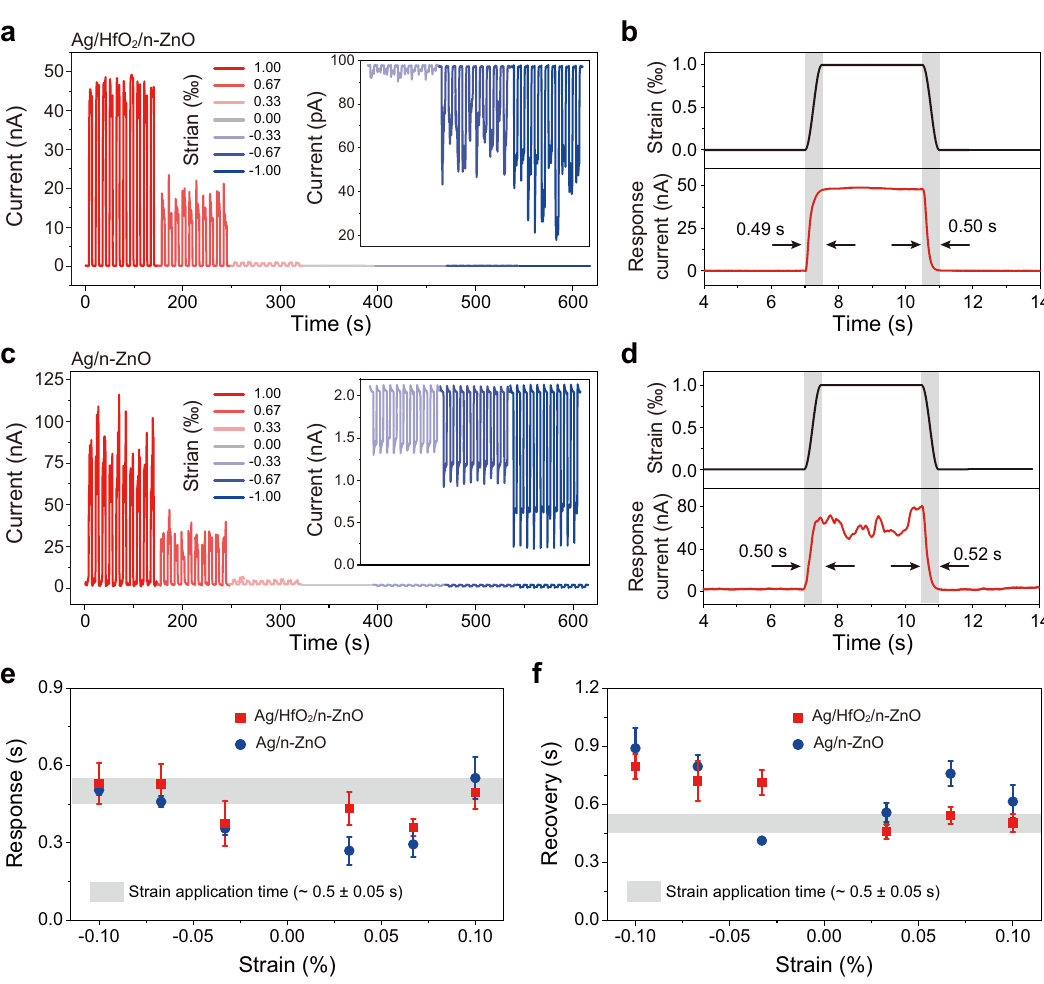
Fig. 4 Dynamic current of the Ag/HfO 2 /n-ZnO PTSS and the Ag/n-ZnO SSS response to applied strain. a Current response of the Ag/HfO 2 /n-ZnO PTSS to strain from − 0.10 to + 0.10% at a fi xed bias. The inset is the enlarged image of the current response to compressive strain. b Detailed response current under a tensile strain of 0.10% for Ag/HfO 2 /n-ZnO PTSS. The corresponding response time and recovery time are 0.49 and 0.50 s, respectively. c Current response of the Ag/n-ZnO SSS to strain from − 0.10 to + 0.10% at a fi xed bias of 3 V. The inset is the enlarged image of the current response to compressive strain. d Detailed response current under a tensile strain of 0.10% for Ag/n-ZnO SSS. The corresponding response time and recovery time are 0.50 s and 0.52 s respectively. e , f Statistical response time ( e ) and recovery time ( f ) of the Ag/HfO 2 /n-ZnO PTSS and Ag/n-ZnO SSS strain sensor under different strains, respectively. Time to apply strain is about 0.5 (±0.05) s. The error bars in e , f denote standard deviations of the